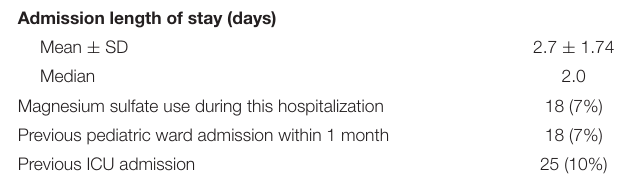
TABLE 1 | Study sample population ( n =